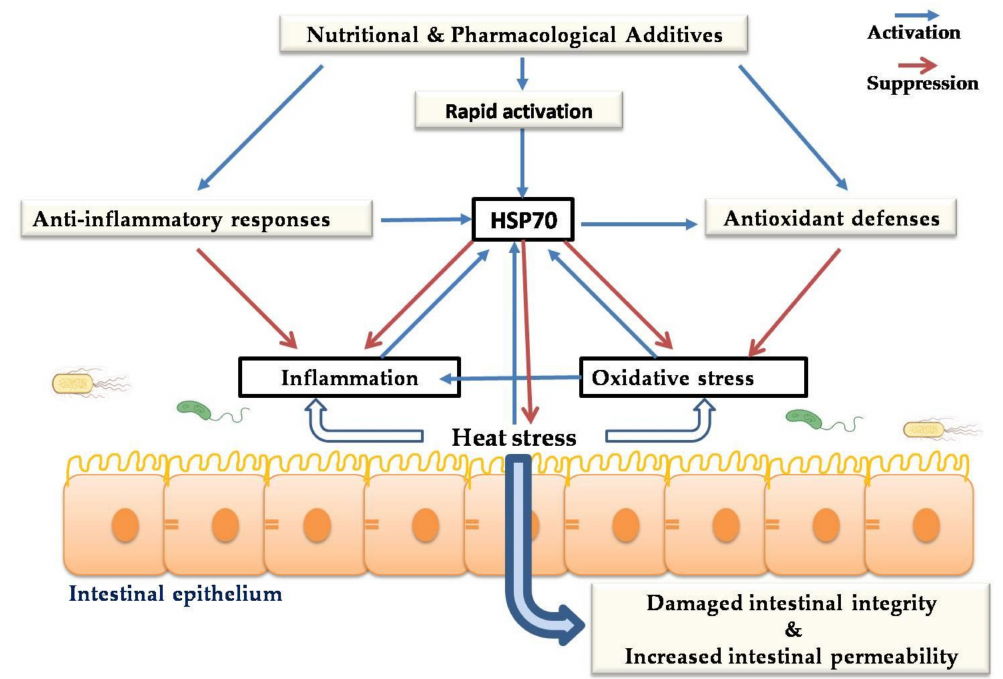
Figure 3. Potential mechanisms underlying the cytoprotective role of HSPs against heat-stress-induced impairment of intestinal